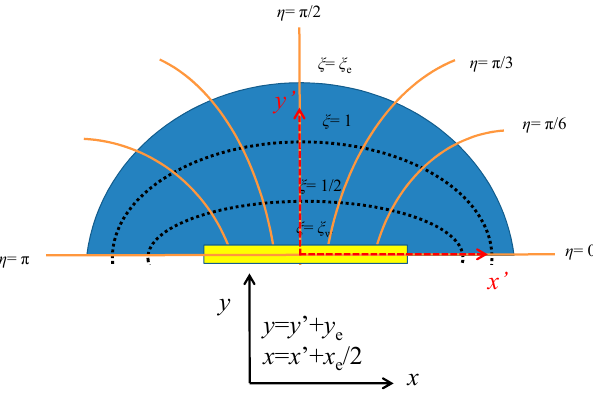
Figure 4. Elliptical coordinate used in the outer elliptical region.